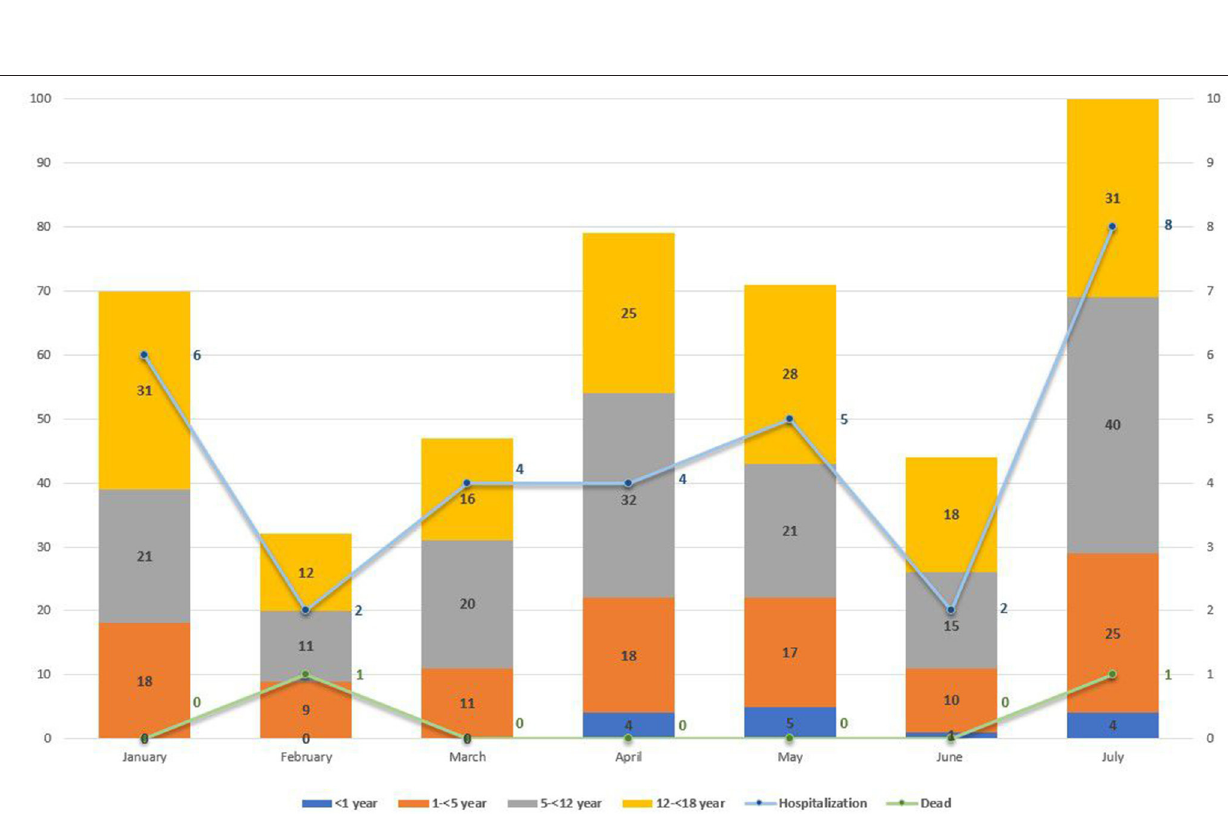
Frontiers in Pediatrics |